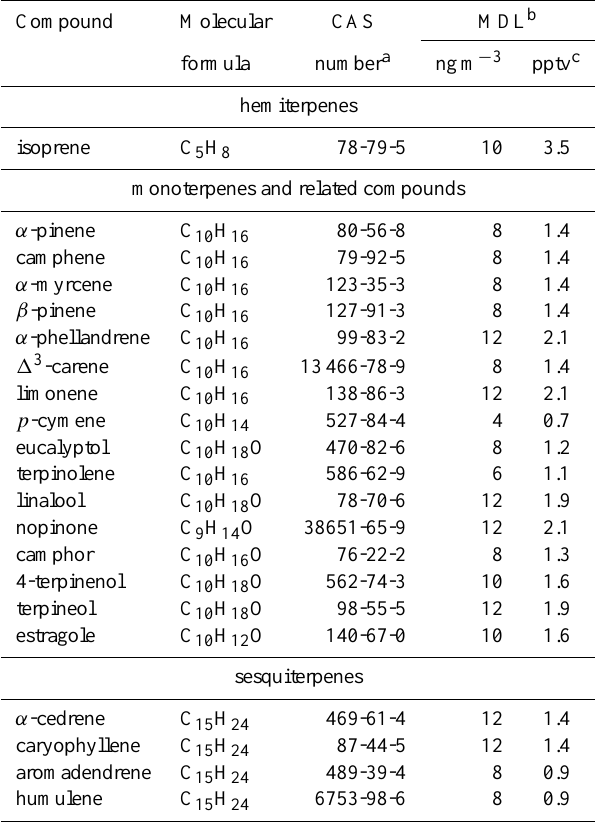
Table 4. Minimum detection limit values (MDL) at 10:1 signal to noise for determination by adsorption/thermal desorption (ATD) with a sample volume of 5l followed by GC ×